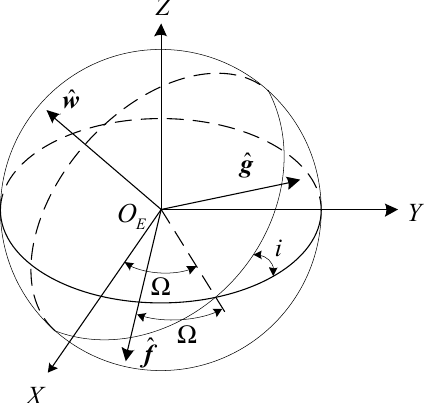
Figure 3. Equinoctial coordinate system with respect to one direct orbit.